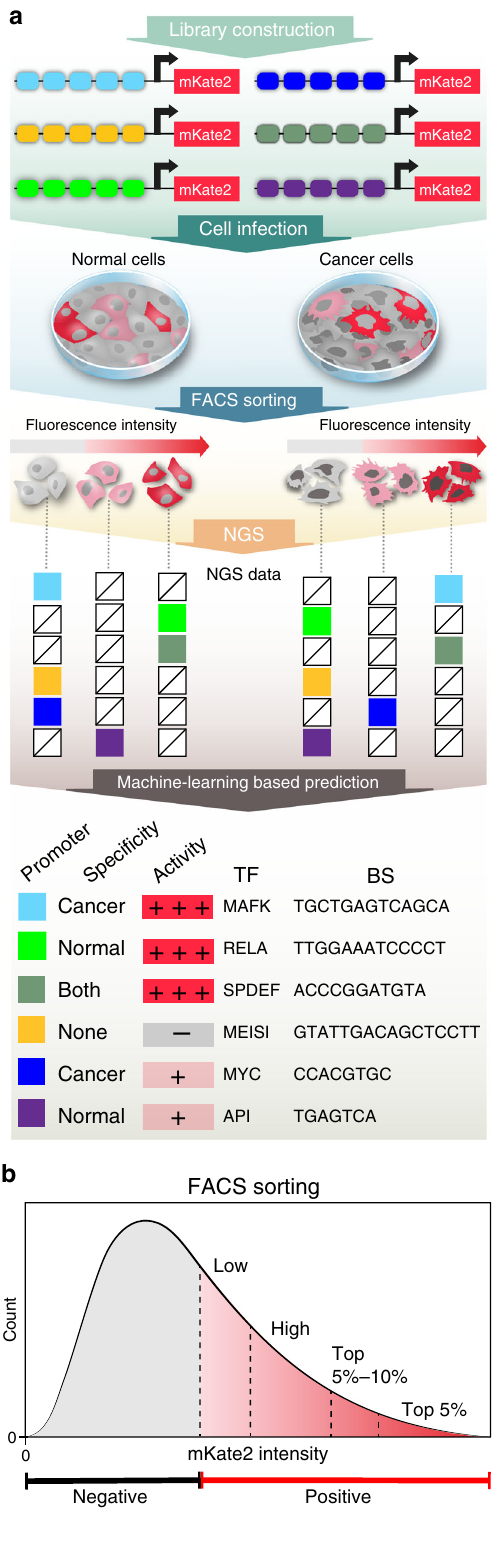
Fig. 1 The experimental and computational pipeline for identifying cell state-speci fi c promoters. a The experimental pipeline consisted of infecting cells with synthetic promoter libraries encoded on lentiviruses, FACS sorting of cells into subpopulations according to fl uorescence intensity, next-generation sequencing (NGS), and computational analysis to